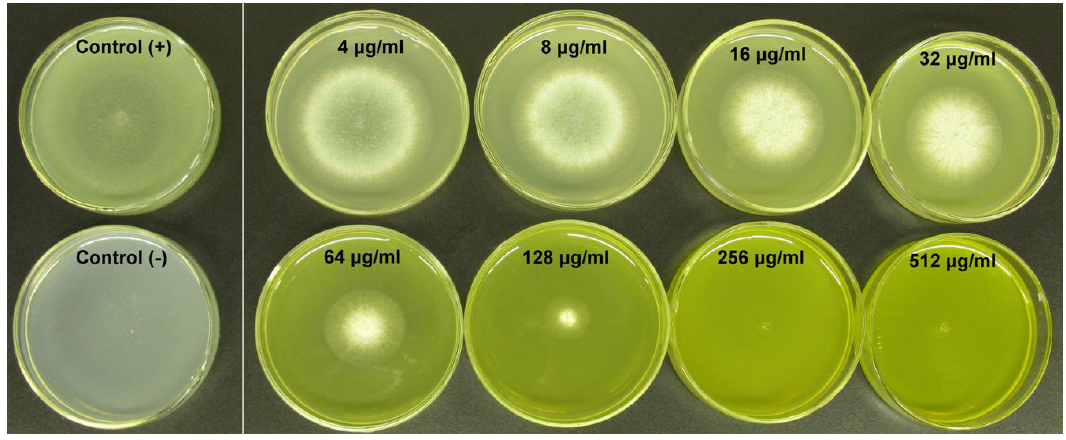
Figure 3. A. fumigatus spores were spotted onto the centre of PDA plates containing different concentrations of BER (512, 256, 128, 64, 32, 16, 8 and 4 μ g/mL), and control (+)